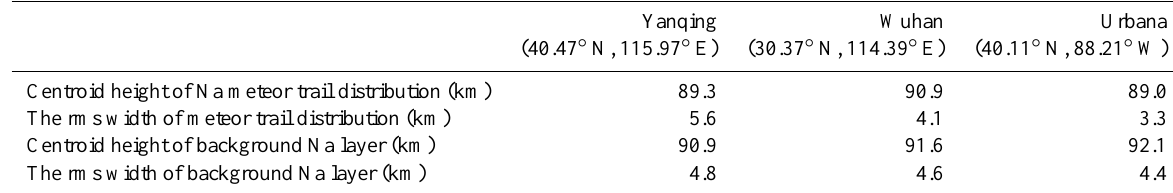
Table 1. The parameters of meteor trails and background Na layer observed by different